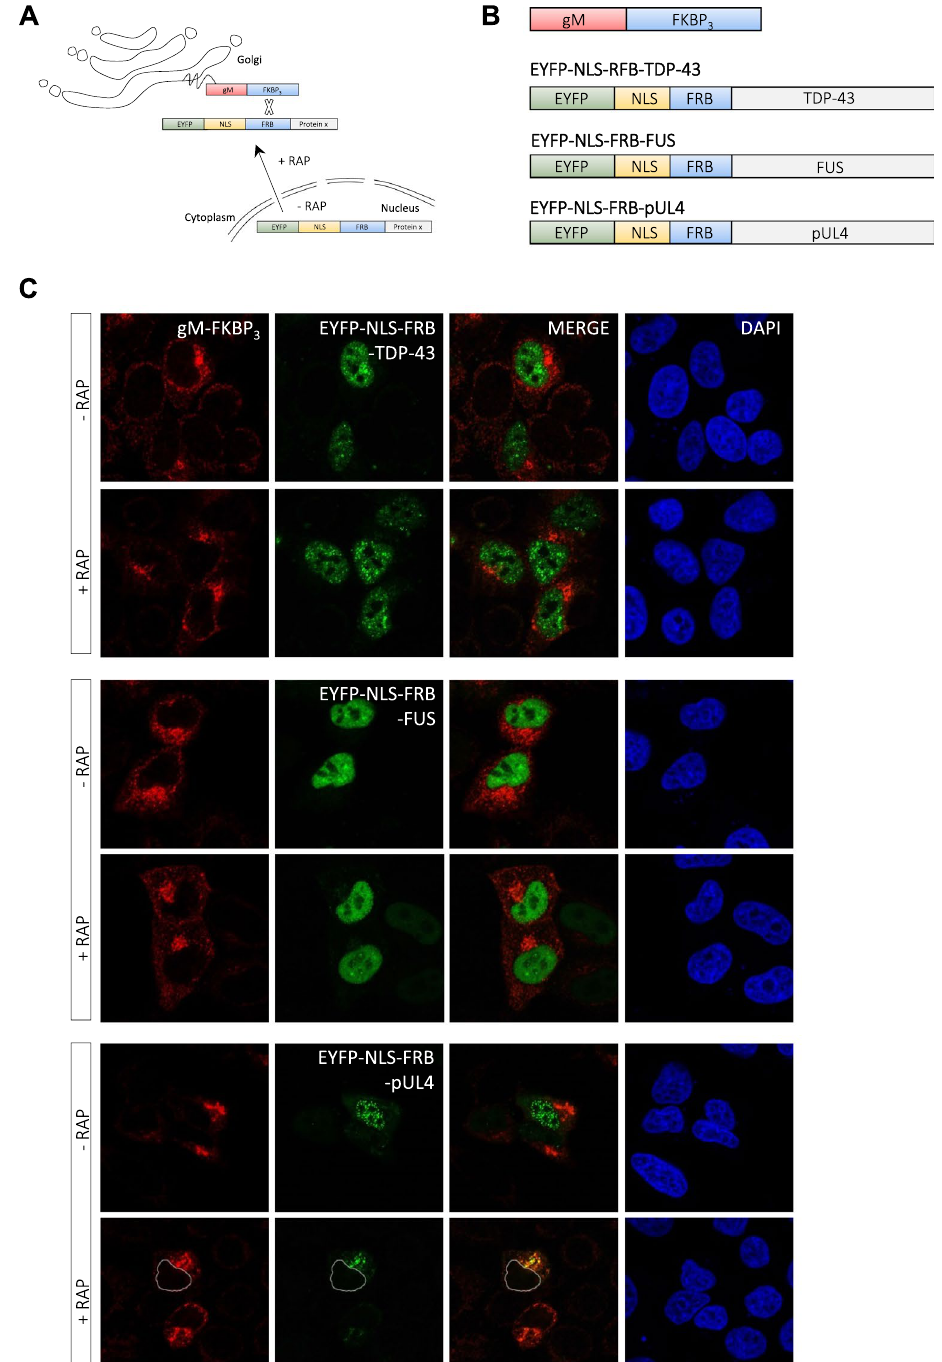
Figure 5. TDP‐43 and FUS are not actively exported in the NEX‐TRAP nuclear export assay. ( A ) Schematic diagram of the NEX-TRAP nuclear export assay. ( B ) Schematic diagram of fusion proteins used in the NEX-TRAP assay. ( C ) HeLa cells were co-transfected with a gM-FKBP 3 construct and constructs encoding either pEYFP-NLS-FRB-TDP-43 or pEYFP-NLS-FRB-FUS. As a positive control, a plasmid encoding EYFP- NLS-FRB-pUL4 (a known CRM1 cargo) was used. 20 h post-transfection, cells were treated with the protein synthesis inhibitor anisomycin for 10 min and incubated for another 2 h in the presence or absence of rapamycin (RAP). Protein localization was visualized by anti-gM immunostaining (red); EYFP-tagged proteins were visualized directly (green); nuclei were visualized by DAPI staining (blue) and are marked by dashed lines. Scale bars: 10 μ